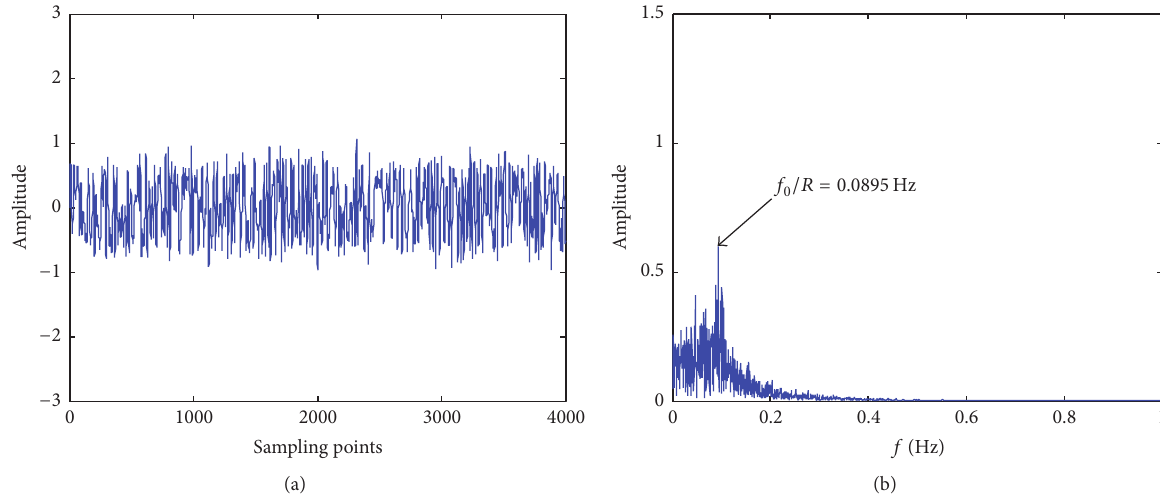
Figure 18: Fault diagnosis result with the traditional Duffing oscillator SR method in the heavy wear of floating tile. (a) Time-domain waveform of output signals; (b) frequency spectrum of output signals. The system parameters are set to 𝜀 = 1/10 , 𝑅 = 100 , 𝑎 = 0.62 , 𝑏 = 3.3 , and 𝑘 = 0.32